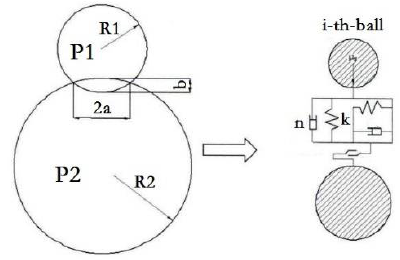
Figure 7. Vibration model of the particle.